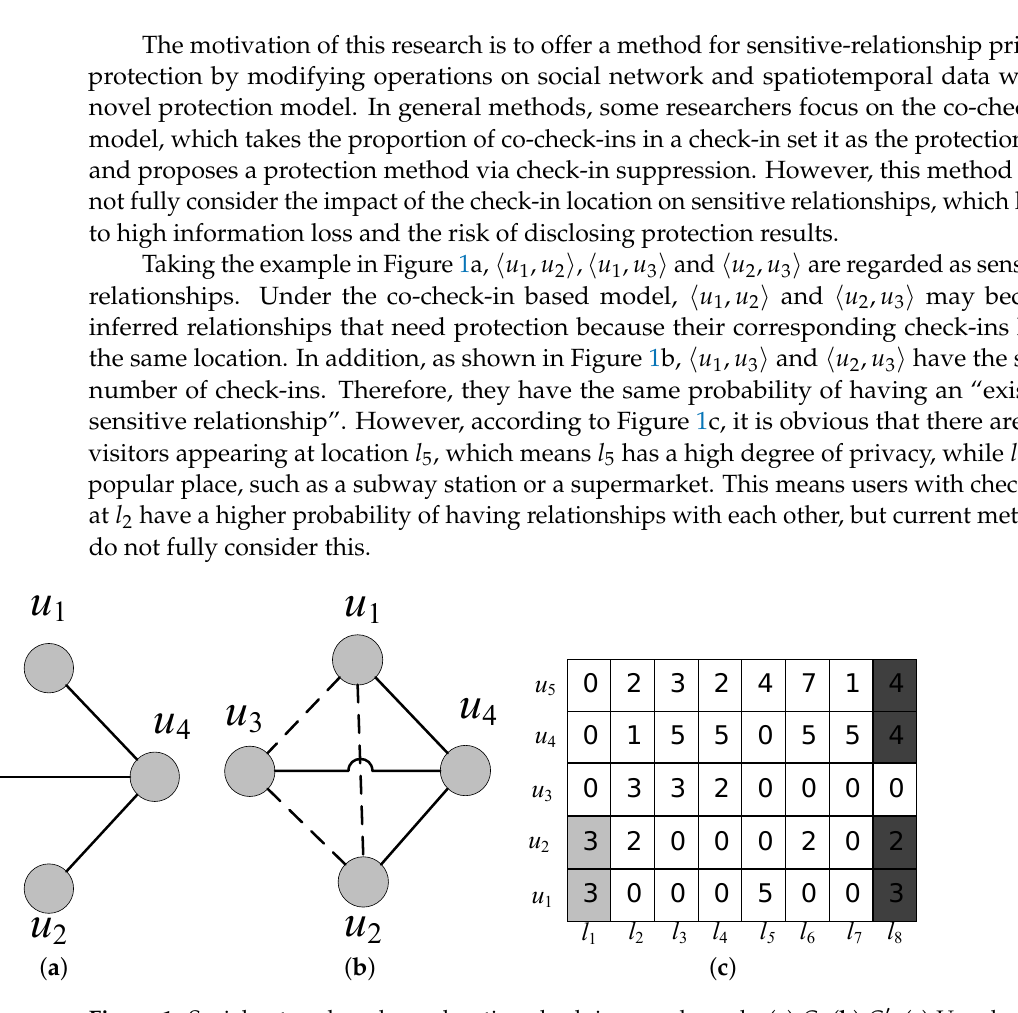
Figure 1. Social network and user location check-in record graph: ( a ) G ; ( b ) G (cid:48) ; ( c ) User location check-in distribution